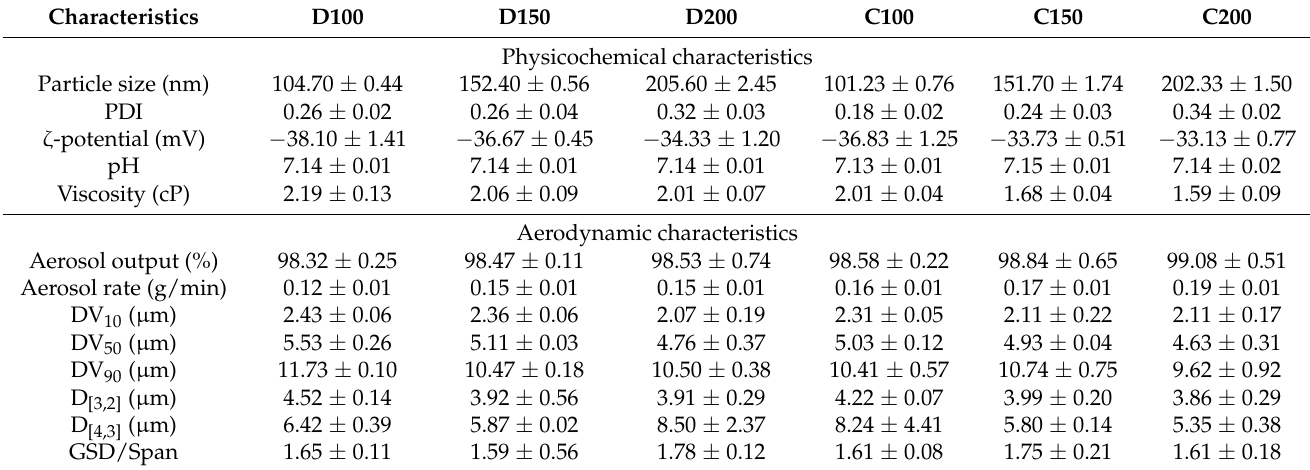
Table 4. Physicochemical and aerodynamic characteristics of DTX- and CCM-loaded